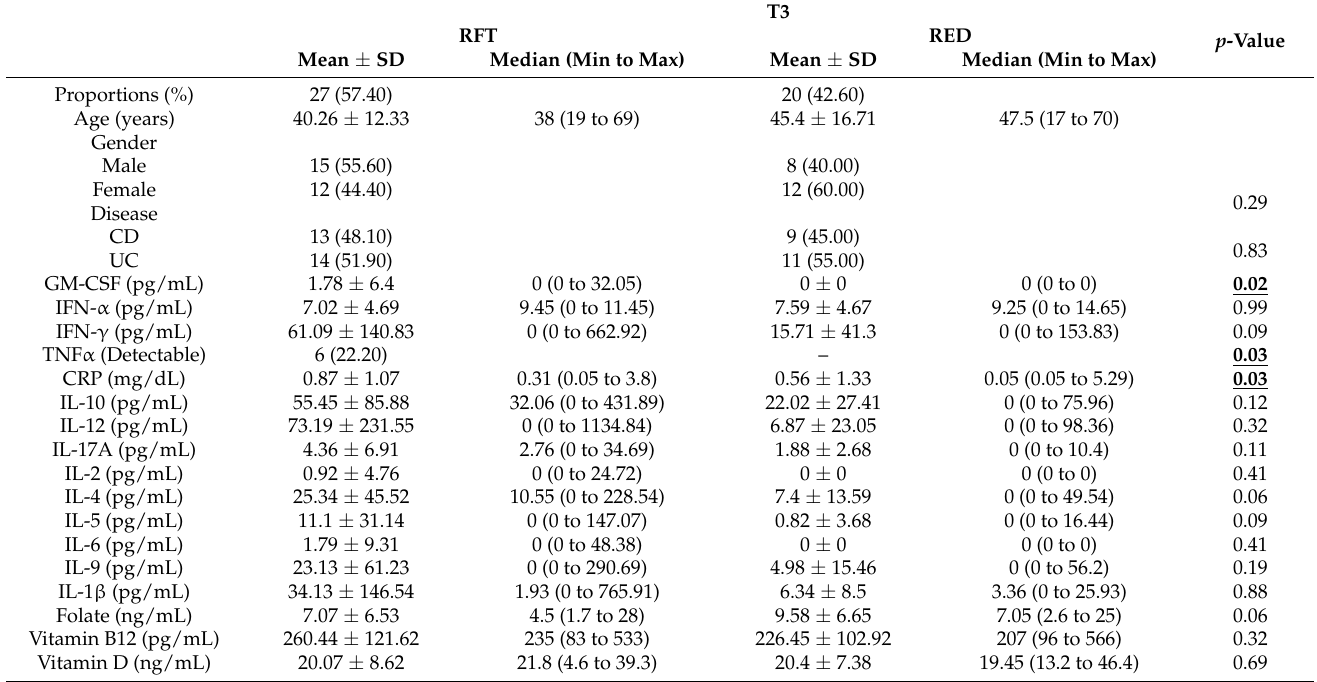
Table 3. Description of the whole sample in T3 according to the type of treatment. (N: 47). Statistically significant differences ( p -value ≤ 0.05) are underlined in bold.